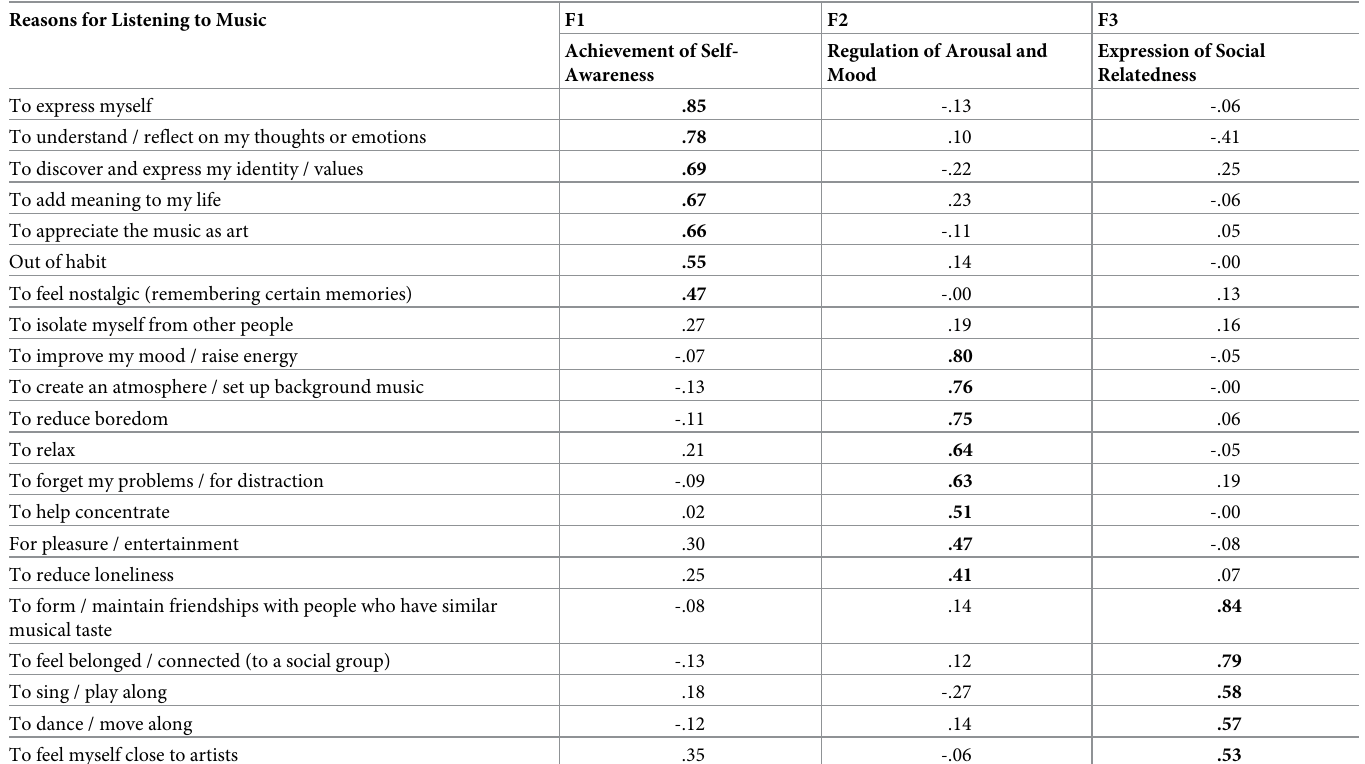
Table 3. Factor analysis for the RL general